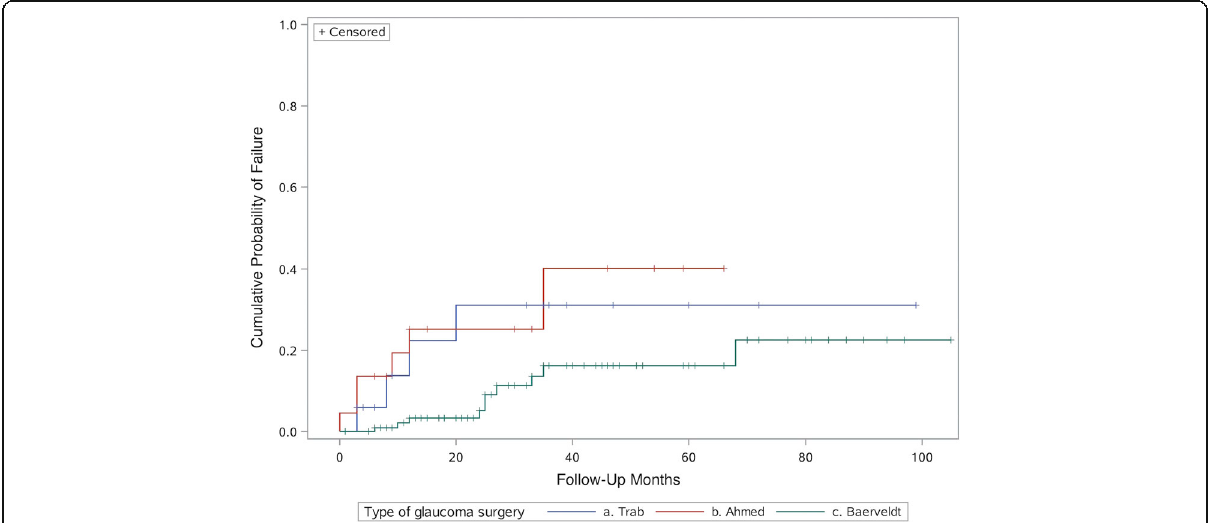
Fig. 1 Cumulative probability of failure from any cause. Kaplan-Meier curves showing cumulative probability of failure from any cause. Ahmed and trabeculectomy were similar ( p = 0.93, Wilcoxon test). Baerveldt differed significantly from trabeculectomy ( p = 0.0054, Wilcoxon test) and from Ahmed ( p = 0.0008, Wilcoxon test)